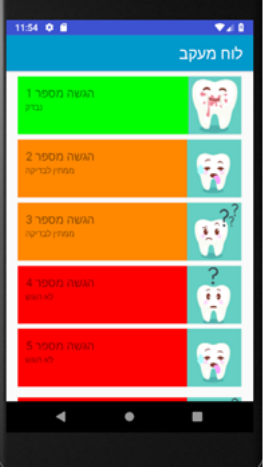
Figure 15. Photo panel screen for the patient: A button on each line allows a photograph to be taken at each prescribed time, and opens the camera.